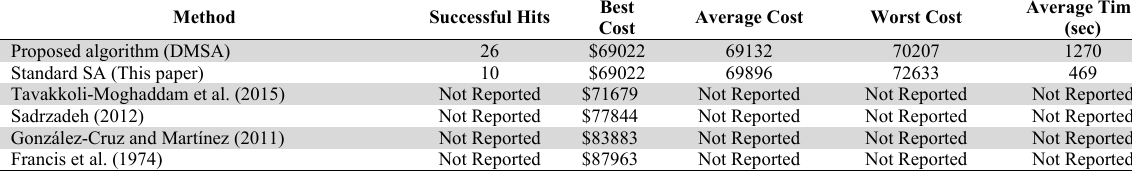
Fig. 15. The best solution obtained by proposed approach for Problem 2 A comparison of the performances of different methods on Problem 2 over 30